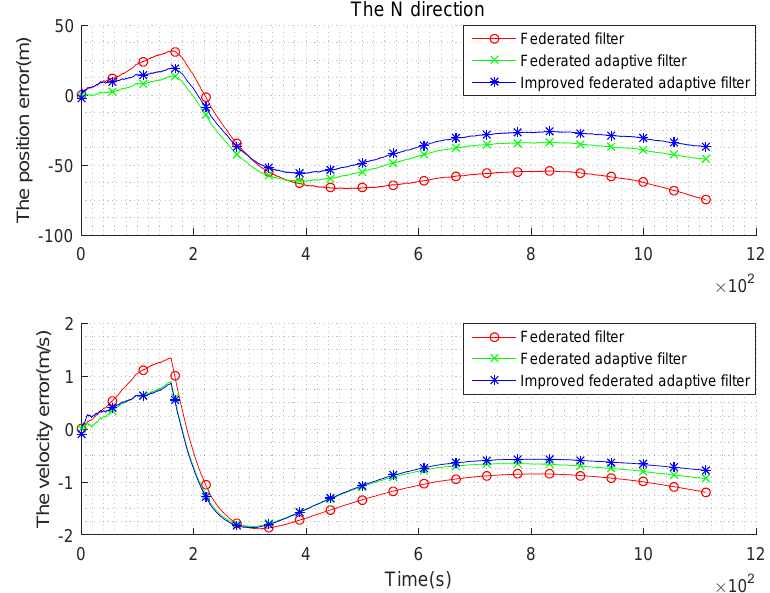
Figure 14. Comparison of the navigation error with time-varying state noise and biased estimation in N